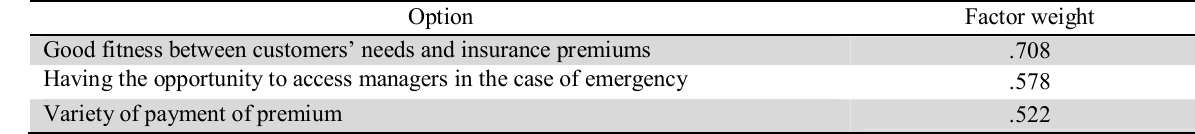
The summary of factors associated with pricing strategy